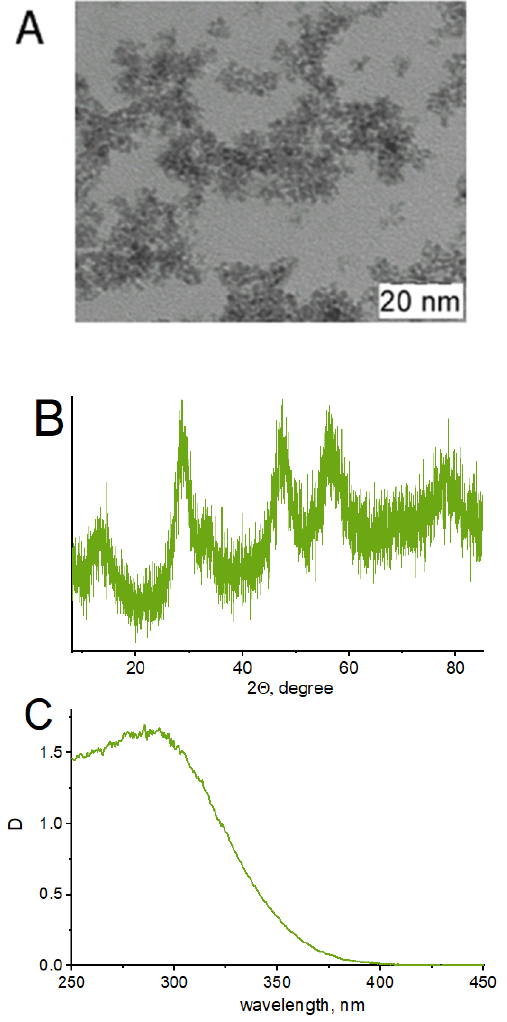
Figure 5. TEM image ( A ); XRD data ( B ); and UV-vis spectrum ( C ) of CeO 2 nanoparticles.